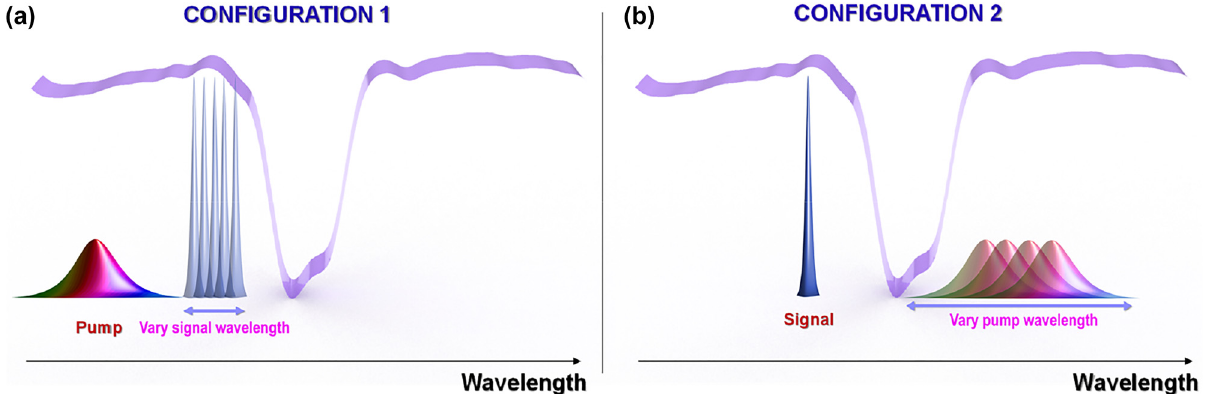
Figure 1: Two pump-probe configurations for achieving XPM-based pulse train generation, relative to the grating stopband (purple). (a) Configuration 1: signal wavelength is tuned close to the blue edge and pump wavelength is fixed far from the grating resonance. (b) Configuration 2: pump wavelength is tuned close to the red edge and signal wavelength is fixed on the blue edge. The grating spectrum, pump and signal placement are drawn versus